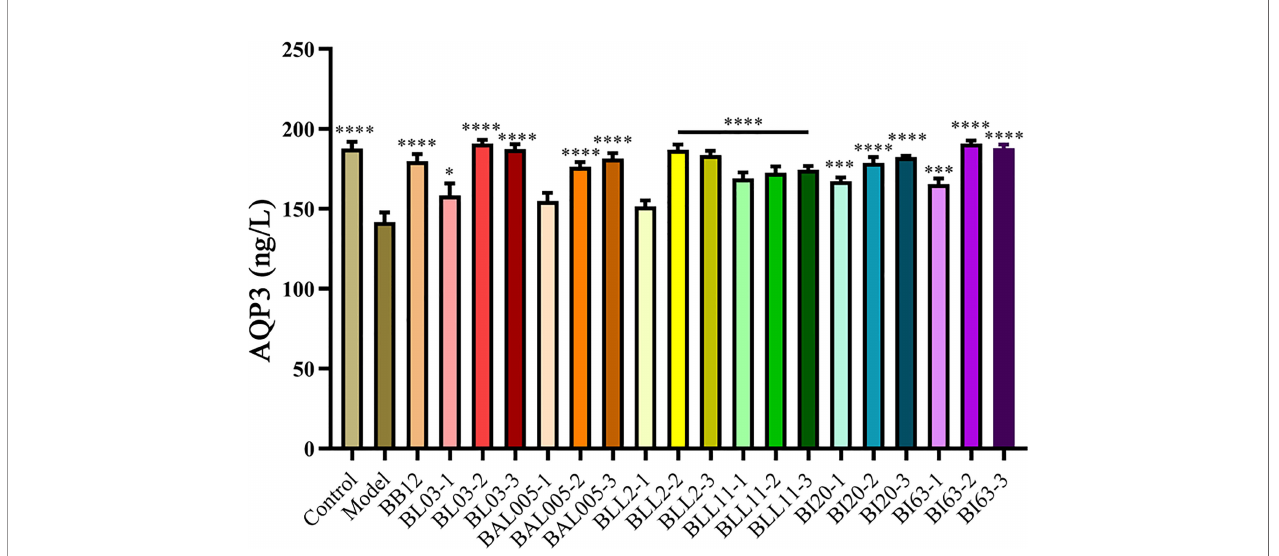
FIGURE 2 | The expression of AQP3 in serum. There is a signi fi cant difference between the bacterial intervention group and the model group, where * means P < 0.05, ***P < 0.005, ****P <